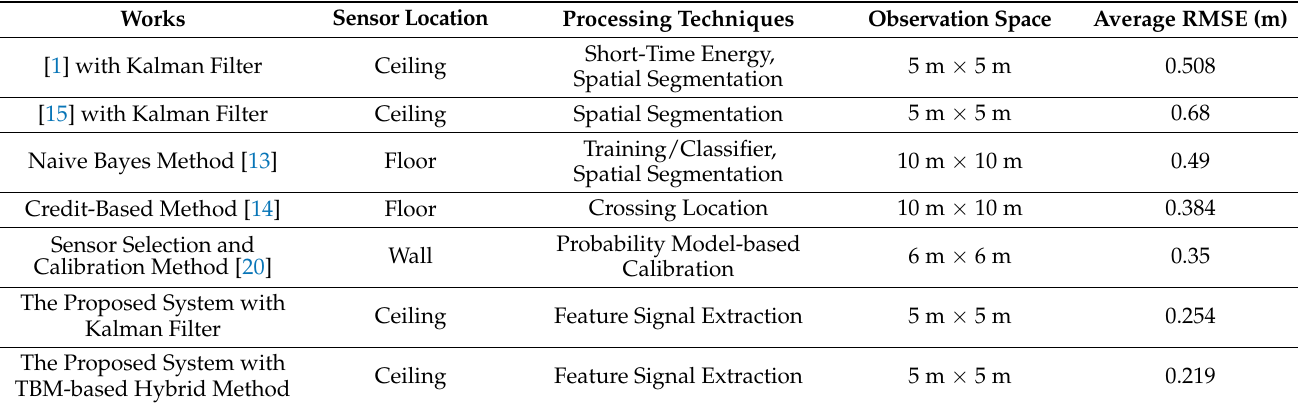
Table 1. Summary of the PIR Detection